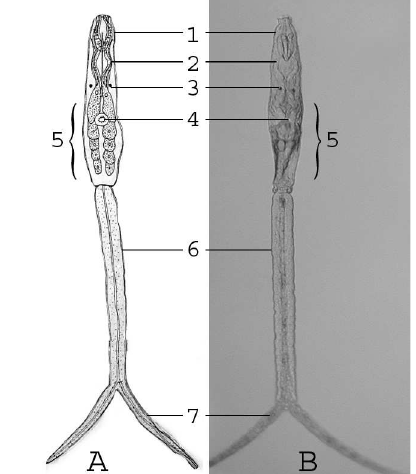
Figure 5. The constitution of Trichobilharzia szidati . A. The schematic struc- ture of cercaria (from [5]), B. The photo of cercaria. 1. Penetration organ, 2. Penetration gland ducts, 3. Pigmented eye-spots, 4. Ventral sucker, 5. Penetration glands (5 pairs), 6. Tail stem, 7.